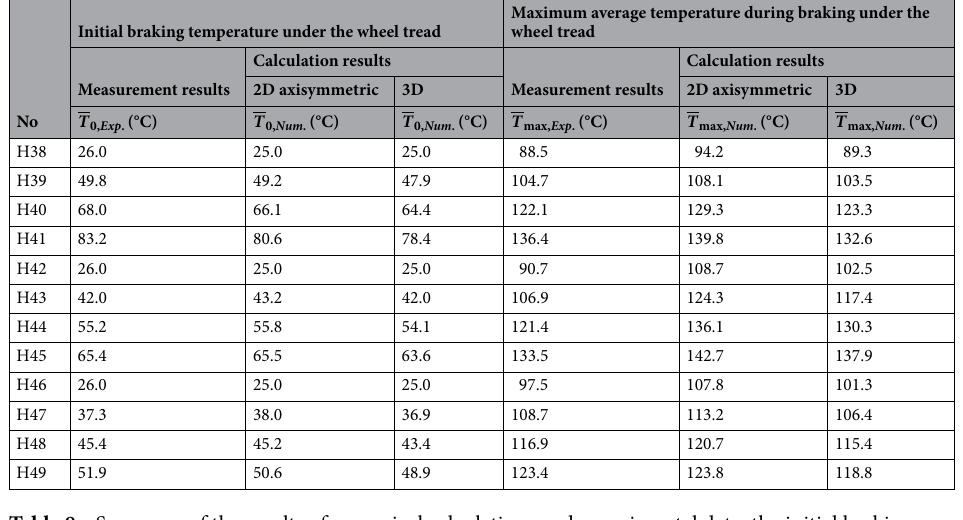
Initial braking temperature under the wheel